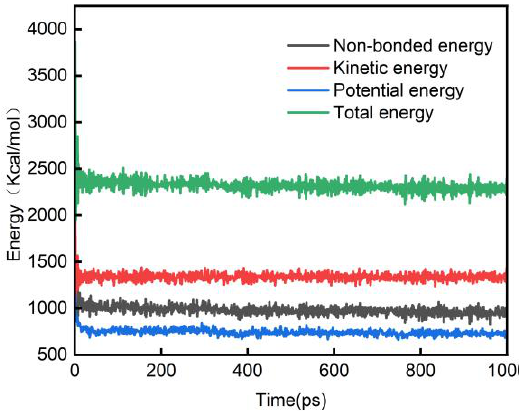
Figure 2. Energy – time variation . Figure 2. Energy–time variation.